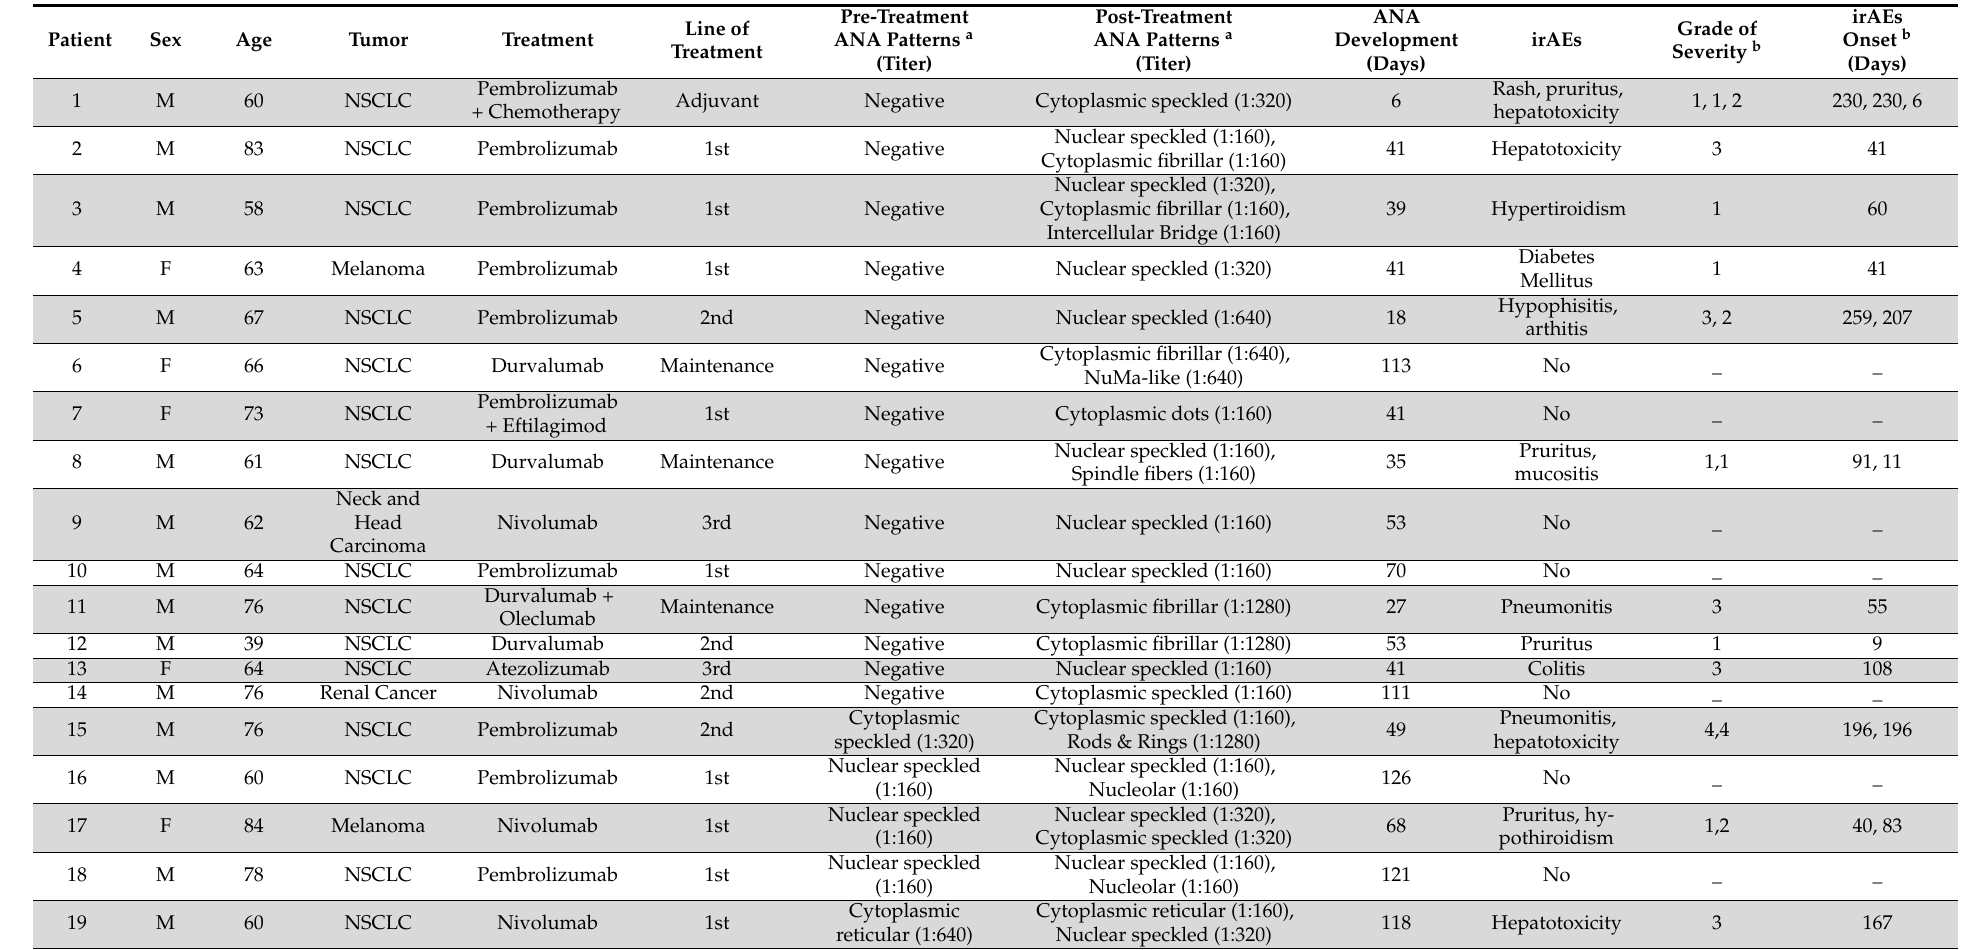
Table 2. Clinical features and ANA patterns in pre- and post-treatment samples of patients who developed ANA de novo during ICI